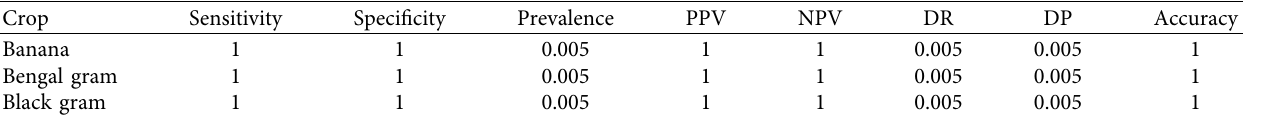
Table 3: Isolation forest